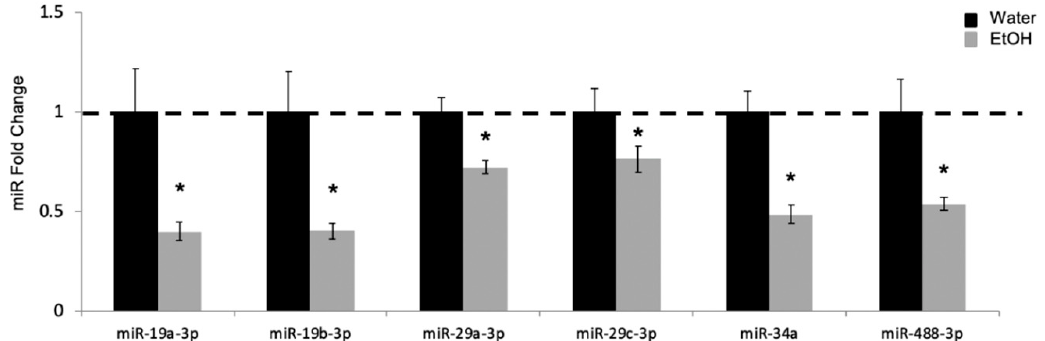
Figure 3. Ethanol treatment during peri-puberty alters microRNA (miR) expression at PND 44. Effects of repeated binge-pattern EtOH exposure on miR levels in the ventral hippocampus of male rats at PND 44 following repeated binge-pattern EtOH administration paradigm during peri-puberty. Data analyzed by ∆∆ Ct method and depicted as mean ± SEM. N = 10/group, an (*) indicates p < 0.05.